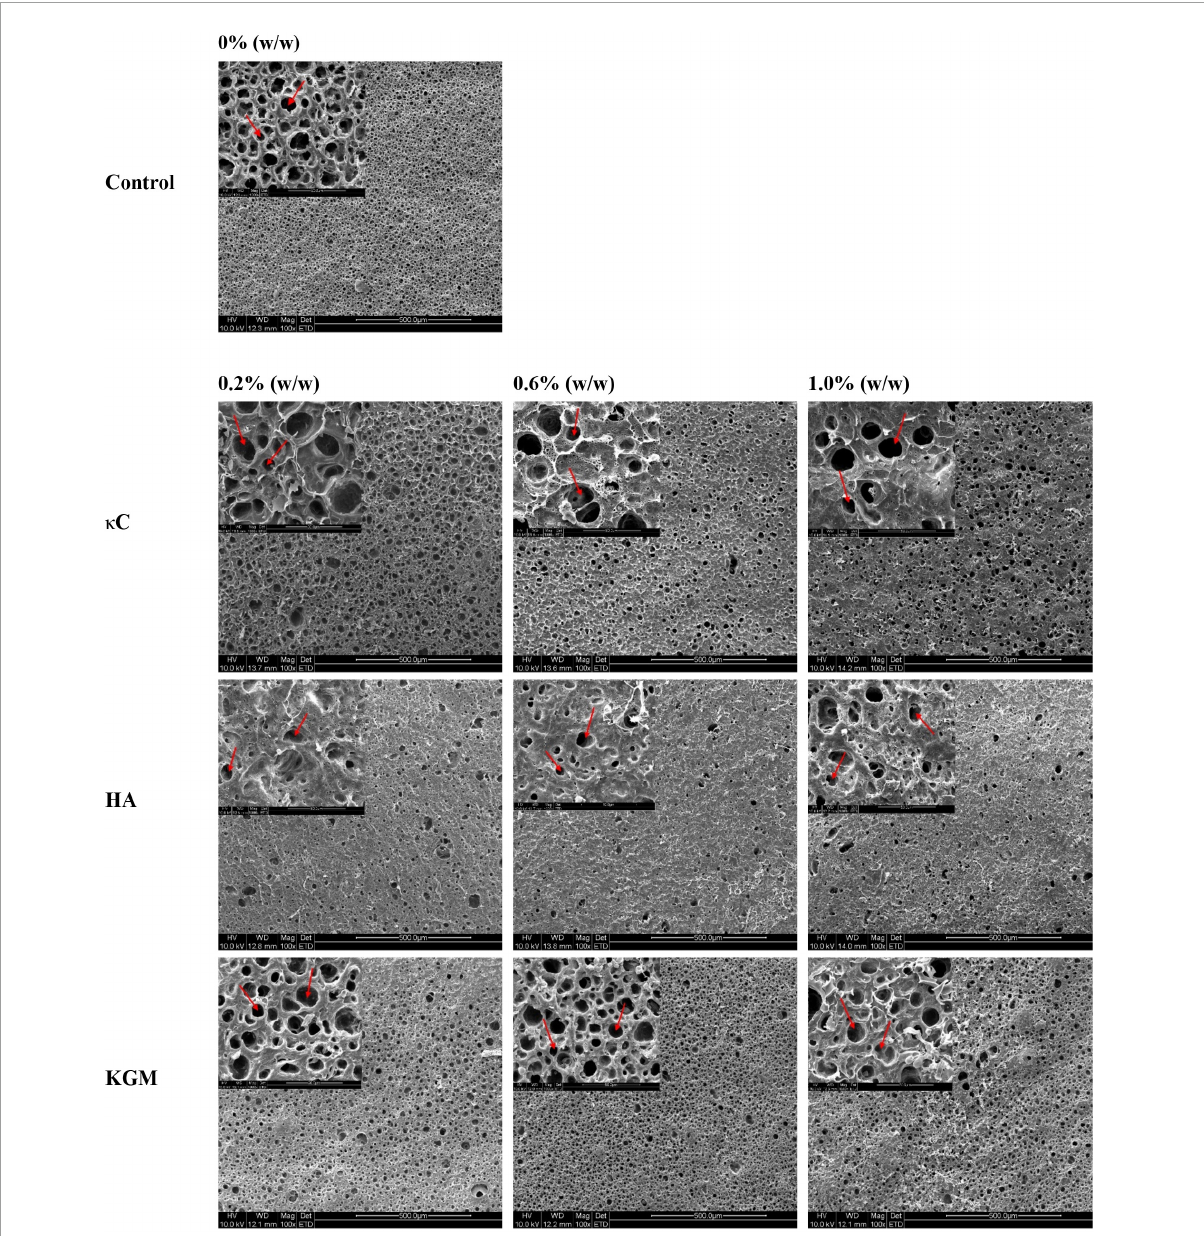
FIGURE7 Scanning electron microscopy (SEM) images (100 × ) of emulsion gels containing different polysaccharides. The holes represent oil droplets; the insert figure represents the details of emulsion gel at (1000 × ). κ C, κ -carrageenan; HA, high-acyl gellan; KGM, konjac glucomannanon.